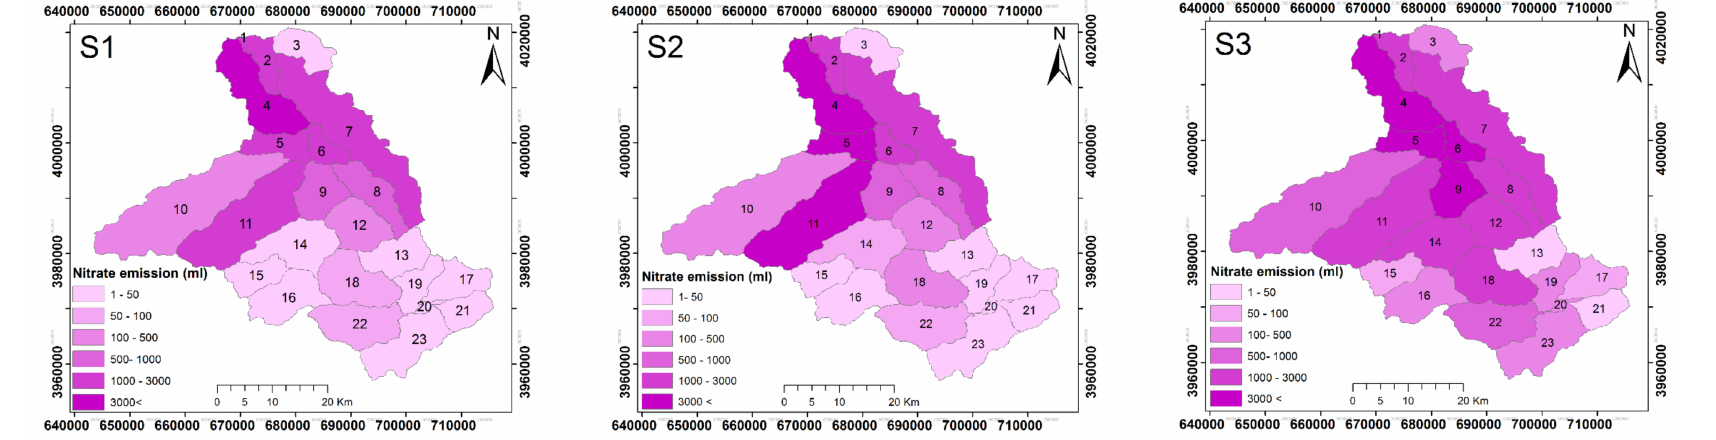
Figure 9. Changes in average annual nitrate load in sub-basin for three land use scenarios (S1, S2 and